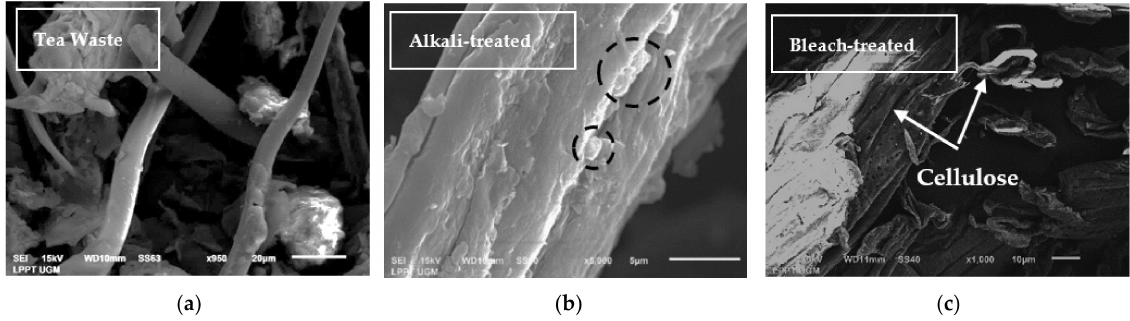
Figure 3. SEM micrographs of ( a ) tea waste, ( b ) alkali-treated tea waste, and ( c ) bleach-treated tea waste.